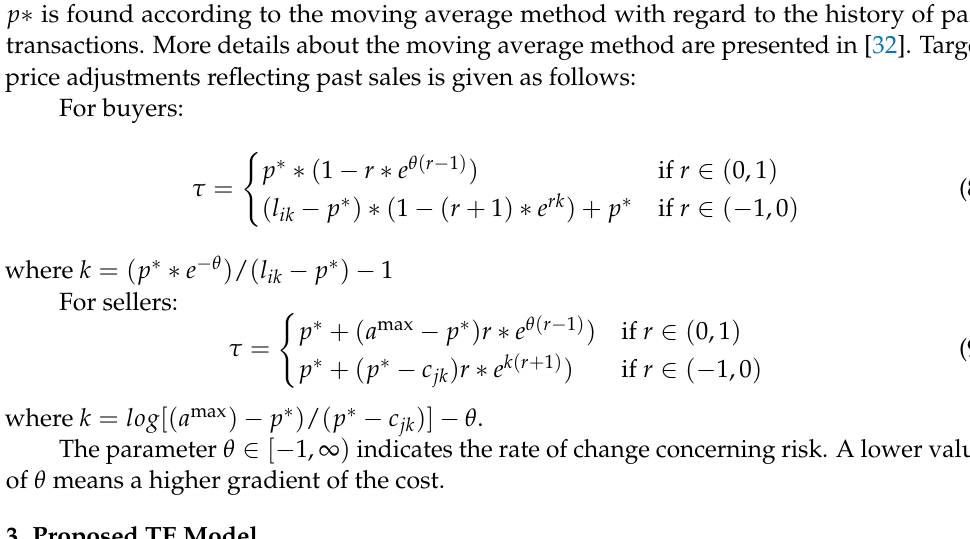
Table 1. Bidding strategy for LAs. Load Bid in First Round Risk Eagerness Factor Priority Rise C1 High Low High Impossible C2 Medium Medium depends on load Possible C3 Low High depends on load